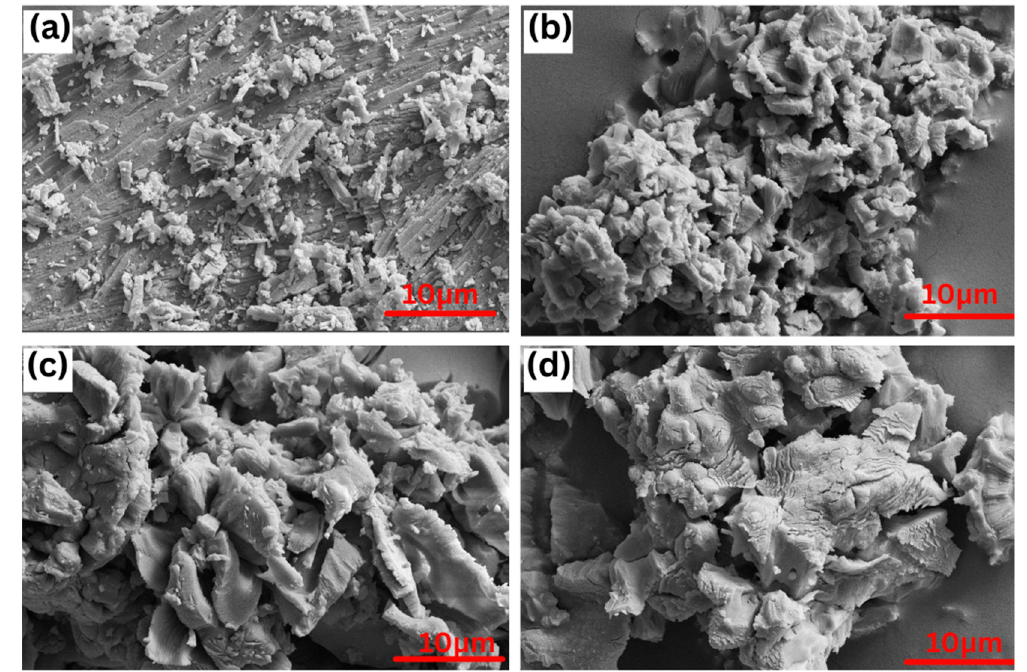
Figure 5. Representative SEM image of the CS powder: ( a ) uncalcined and calcined at ( b ) 700 °C, ( c ) 900 °C, and ( d ) 950 °C with magnification 3000.